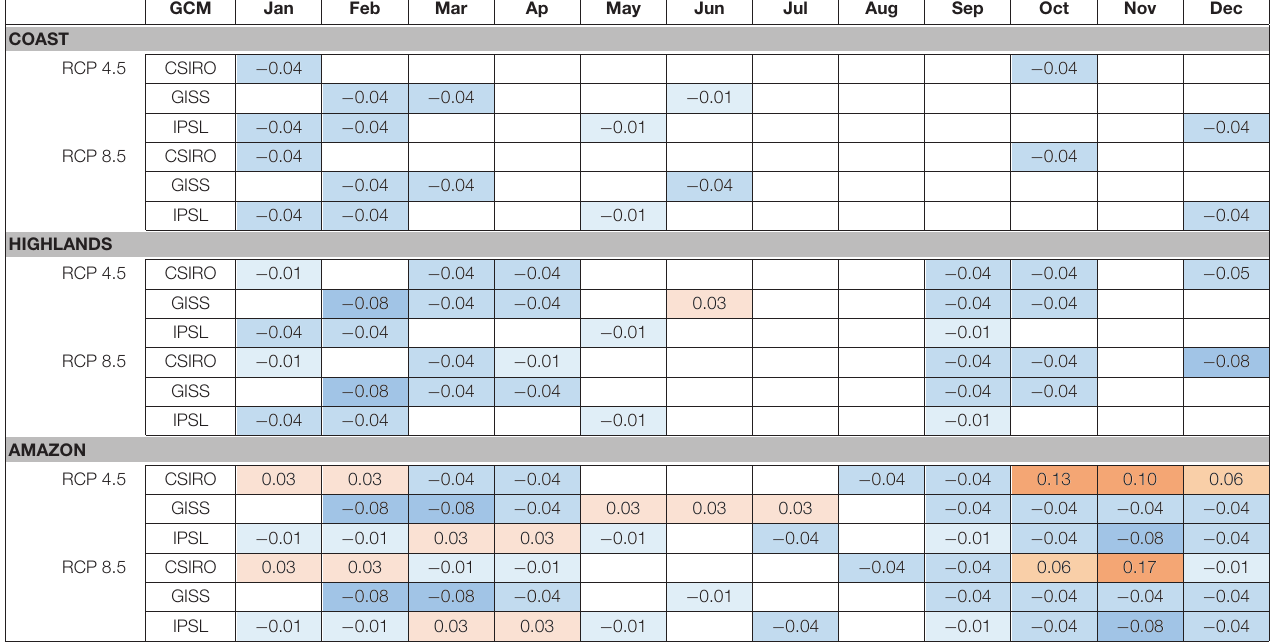
TABLE 7 | Monthly changes of drought probablity for extreme droughts.